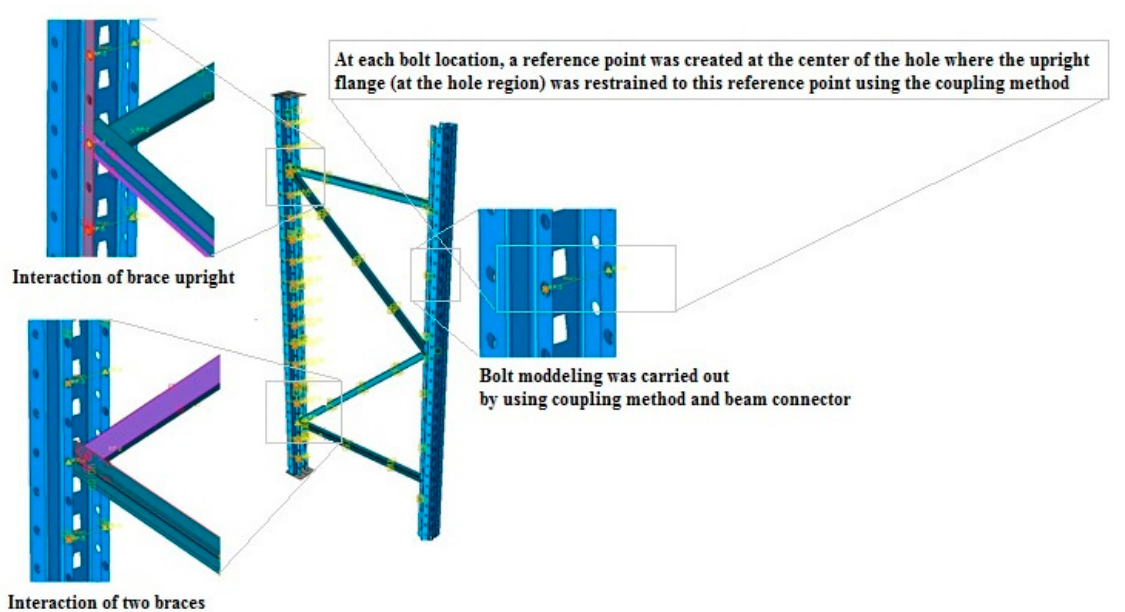
Figure 5. Interaction and connection properties of a typical model.